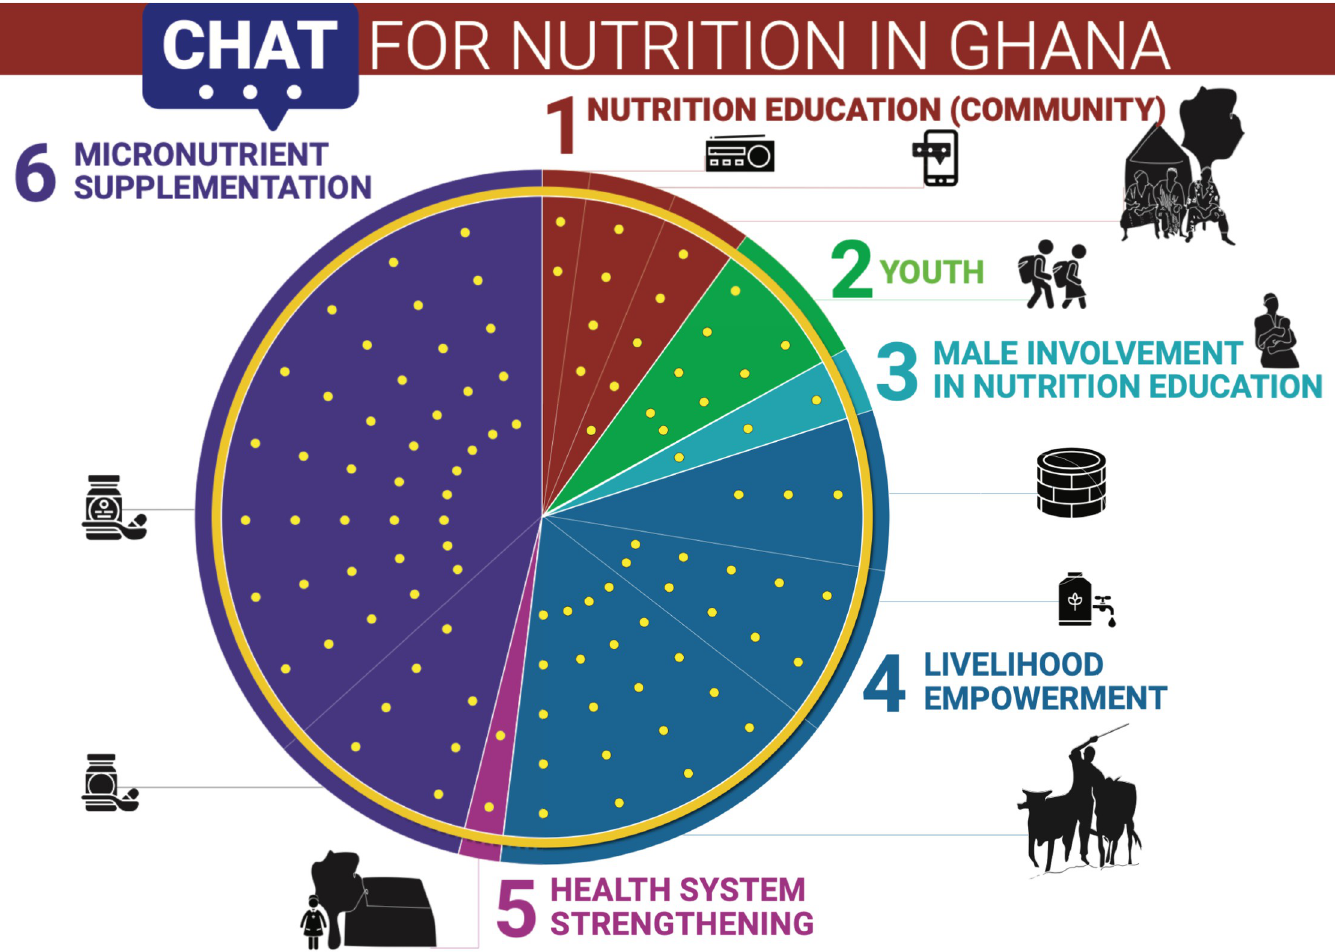
Fig 1. The Navrongo, Ghana modified CHAT board used for the prioritization exercise. ’The Navrongo, Ghana modified CHAT board used for the prioritization exercise,’ Copyright 2005 The Regents of the University of Michigan, is licensed under Creative Commons Attribution 4.0 International Public License (CC BY 4.0) https://creativecommons.org/licenses/by/4.0/legalcode.